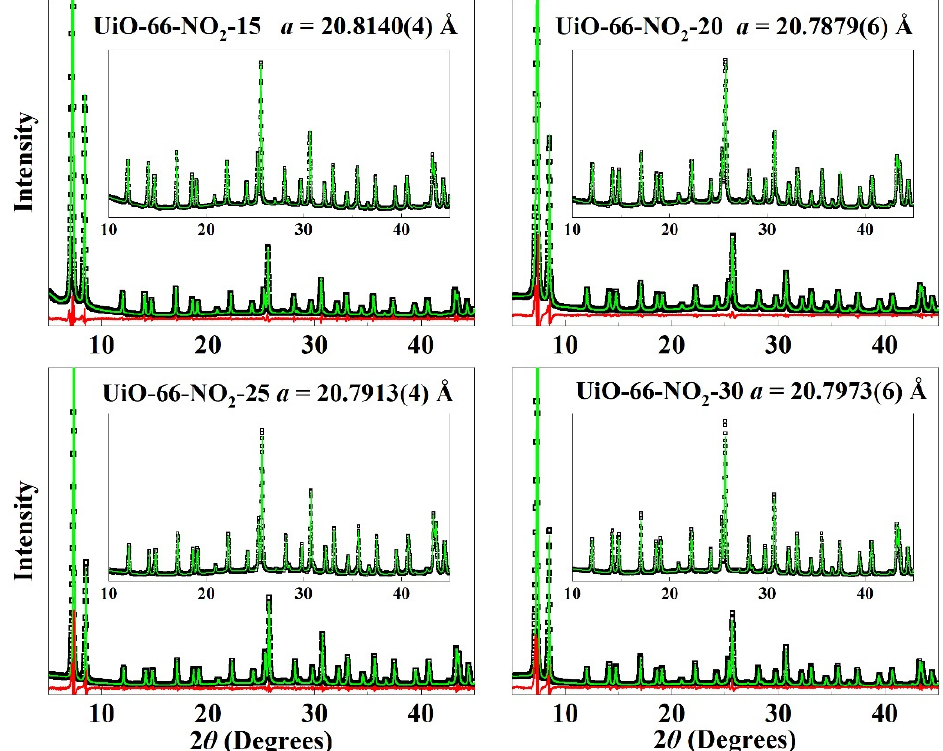
Figure 1. Profile fits to powder X-ray diffraction patterns of UiO-66-NO 2 -X. The points are measured data, the green line is the final fit, and the red line the difference curve. Refined lattice parameters are provided on each panel. The refinement goodness-of-fit wR = 5.61%, 9.40%, 11.60%, and 14.43 respectively, for X = 15, 20, 25, and 30 in UiO-66-NO 2 -X. The inset on each plot is an expanded region of the high angle region.